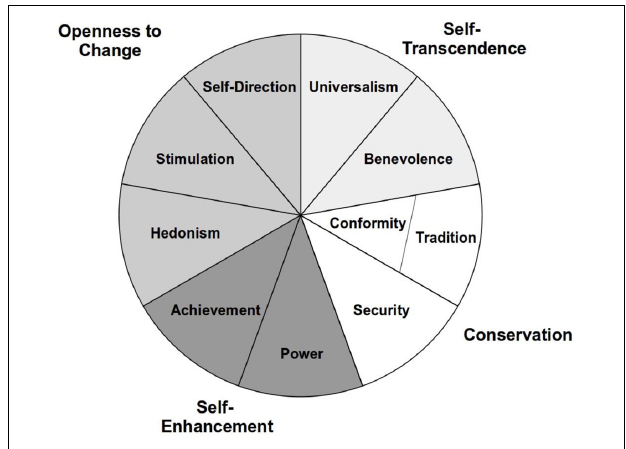
FIGURE 1 | Circular structure of basic human values (based on Schwartz,